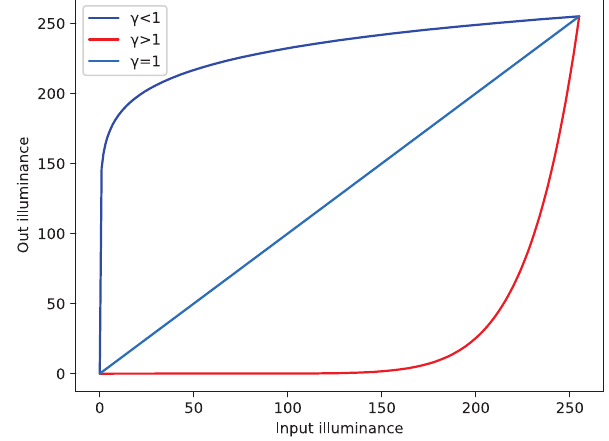
Figure 5. Gamma curves with different